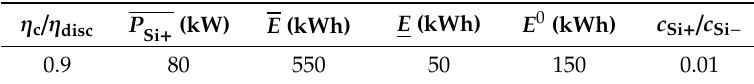
Table 7. Specification of the BESS.